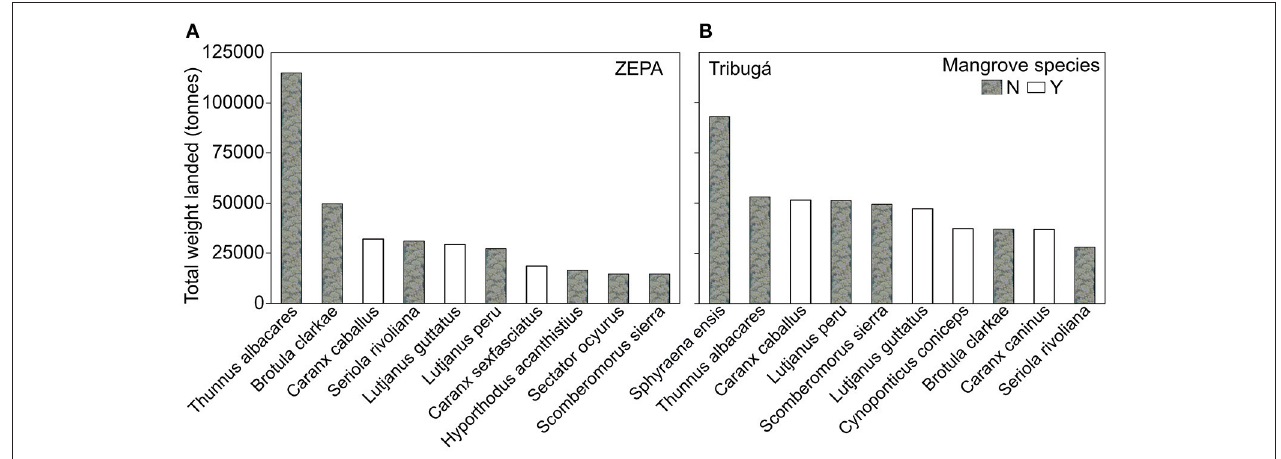
FIGURE 2 | Top 10 species by weight landed (tones) during all the sampling period between 2010 and 2013 in the (A) Exclusive Zone of Artisanal Fishing (ZEPA) and (B) the Gulf of Tribugá. White bars represent mangrove dependent species and mottled grey bars represent species not dependent on